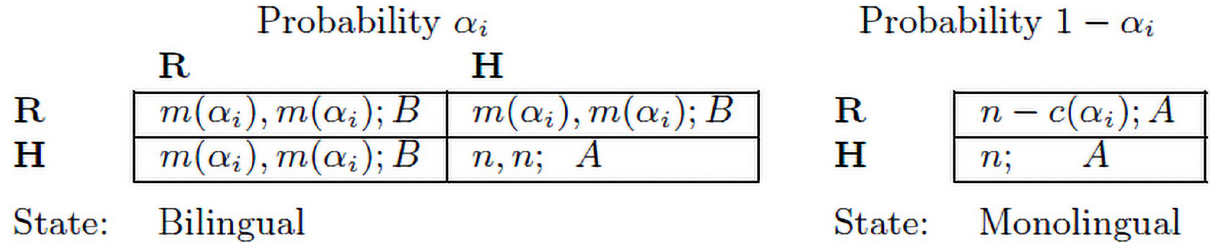
Fig 1. The language use game. The matrix on the left describes the state where two bilinguals meet. The combination of pairs of strategies, R and H , gives rise to cells where a pair of payoffs and the resulting language are shown. The column on the right describes the state where a Bilingual meets a Monolingual. The spoken language will be A , and the payoff to the bilingual depends on the strategy chosen.